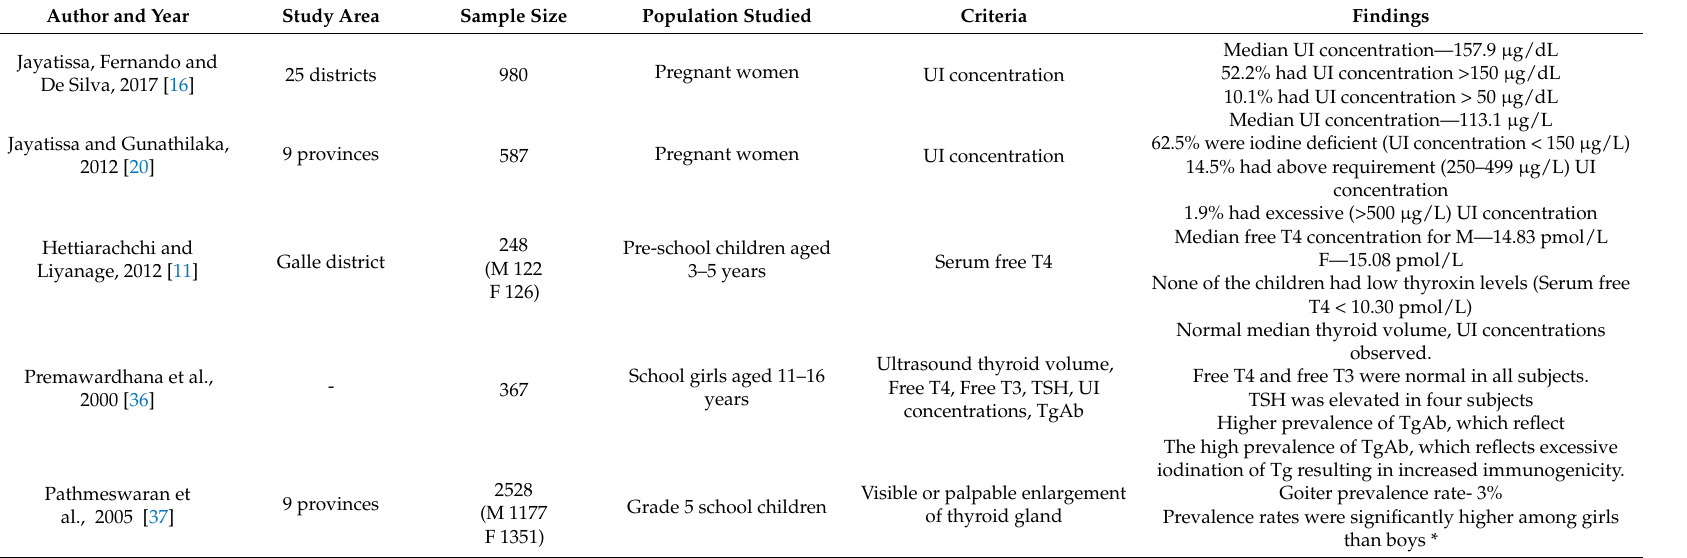
Table 6. Findings related to Iodine deficiency among different population